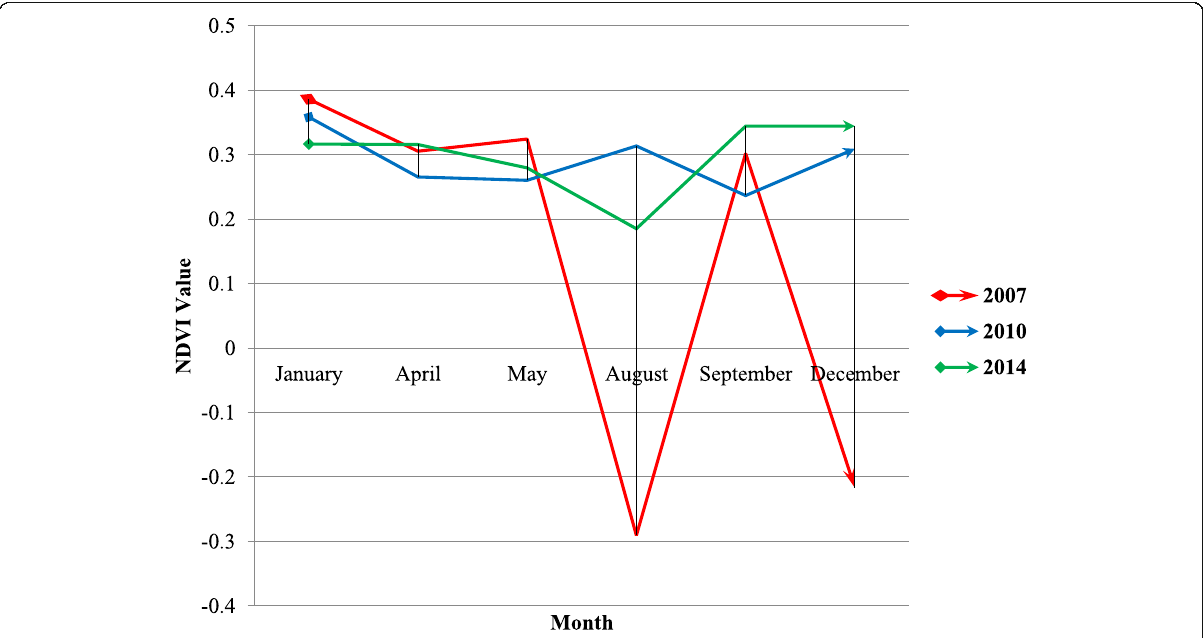
Fig. 4 Average NDVI for the year 2007 compared with 2010 and